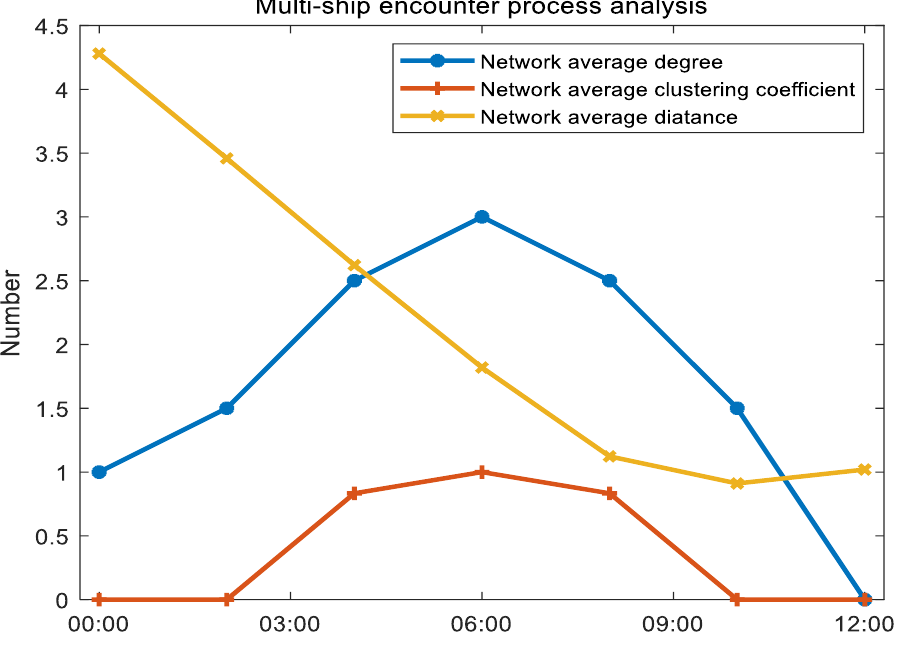
Figure 13. Multi-ship encounter process analysis.